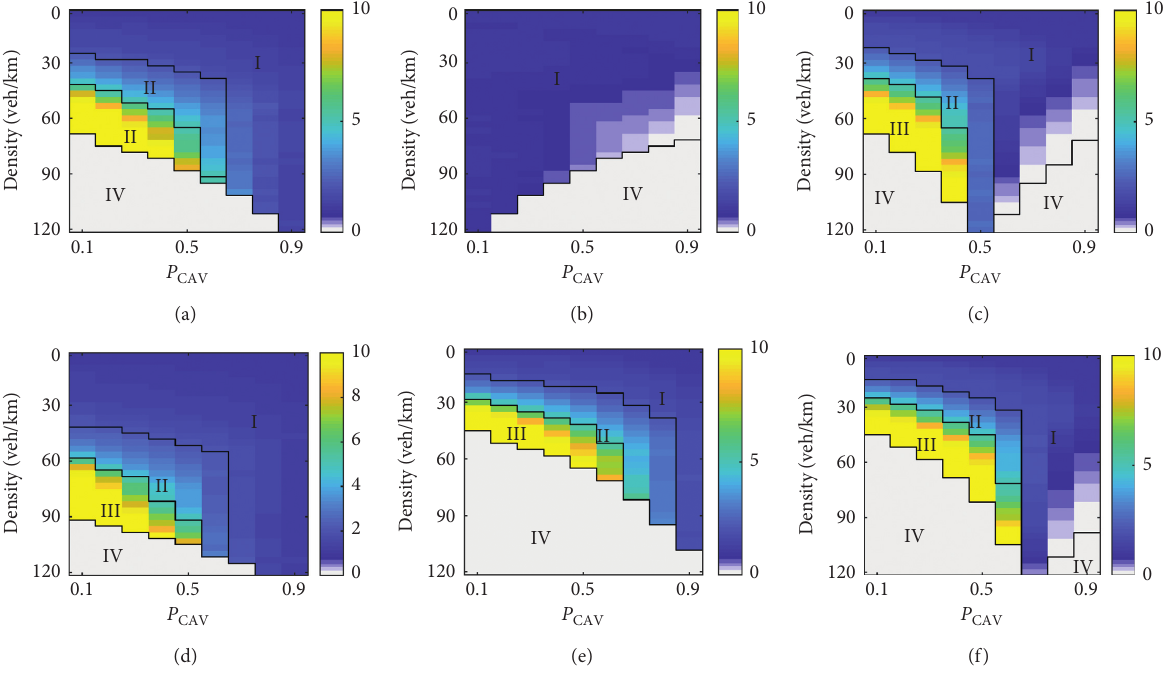
Figure 5: The diagram of ratio r . (a) GC. (b) GM. (c) CM. (d) GCG. (e) CGC. (f)